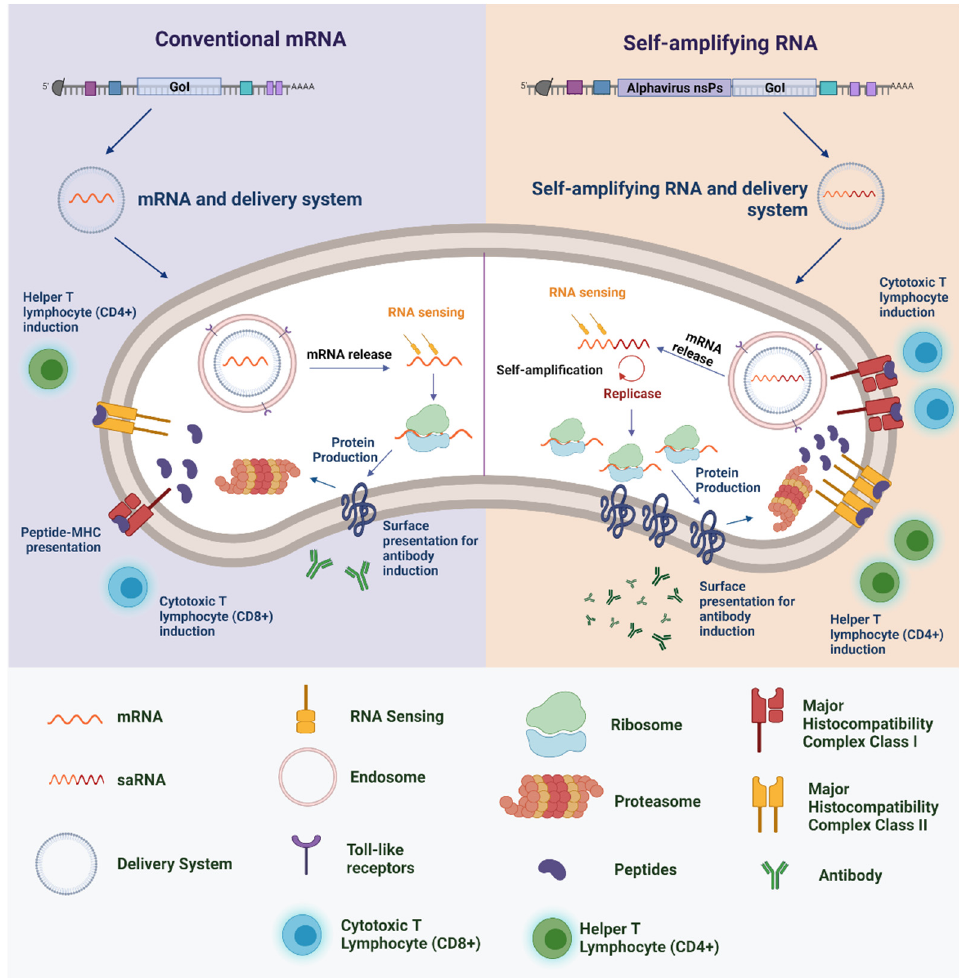
Figure 1. Overview of mRNA and saRNA-based vaccine mechanisms for protein production. Adapted from Maruggi et al. [104]. GoI, gene of interest; MHC, major histocompatibility complex; nsPs, nonstructural proteins. Created with BioRender.com (accessed on 30 September